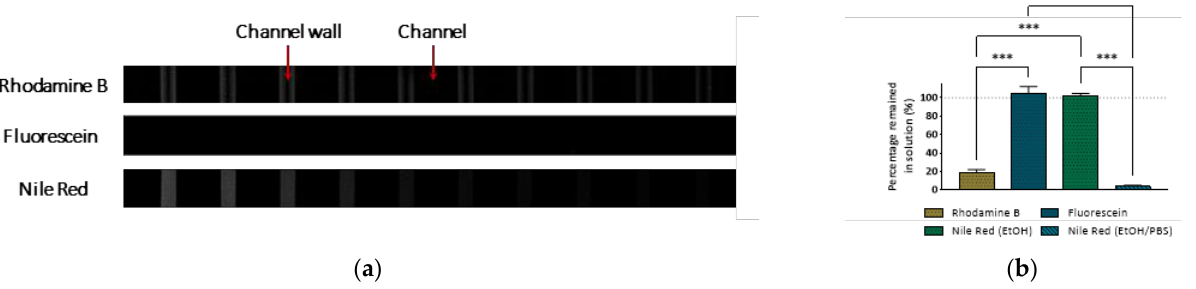
Figure 1. ( a ) Confocal microscopy images of PDMS channel walls following continuous flow of rho- damine B and fluorescein in 1x PBS and Nile red in ethanol/PBS (1:3 v / v ). ( b ) Relative concentration ratio (expressed as a percentage) of 1 µM rhodamine B, 1 µM fluorescein, and 1 µM Nile red in ethanol or ethanol/PBS (1:3 ratio) that remained in solution following 90 min of continuous flow through the PDMS microchannels at 96 µL∙h −1 . Values show Mean ± SD from at least three independent measurements (*** p < 0.001).